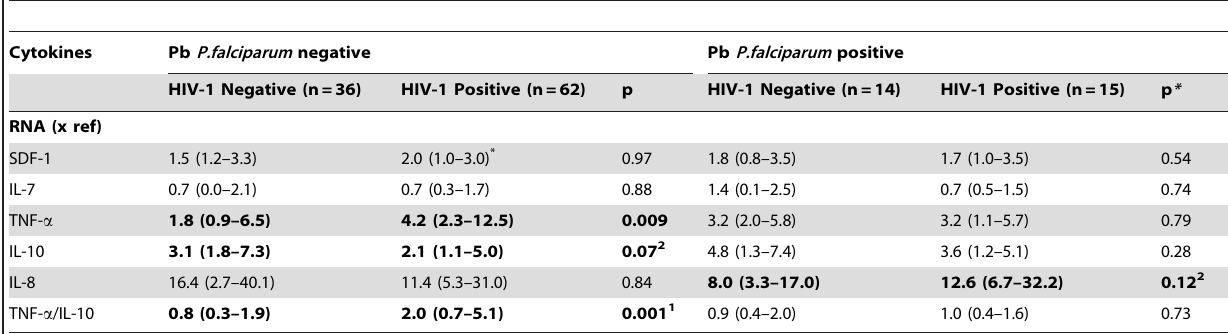
Table 4. Difference in placental cytokine expression levels (RNA) between HIV-1 negative and positive women in relation to peripheral blood Plasmodium falciparum